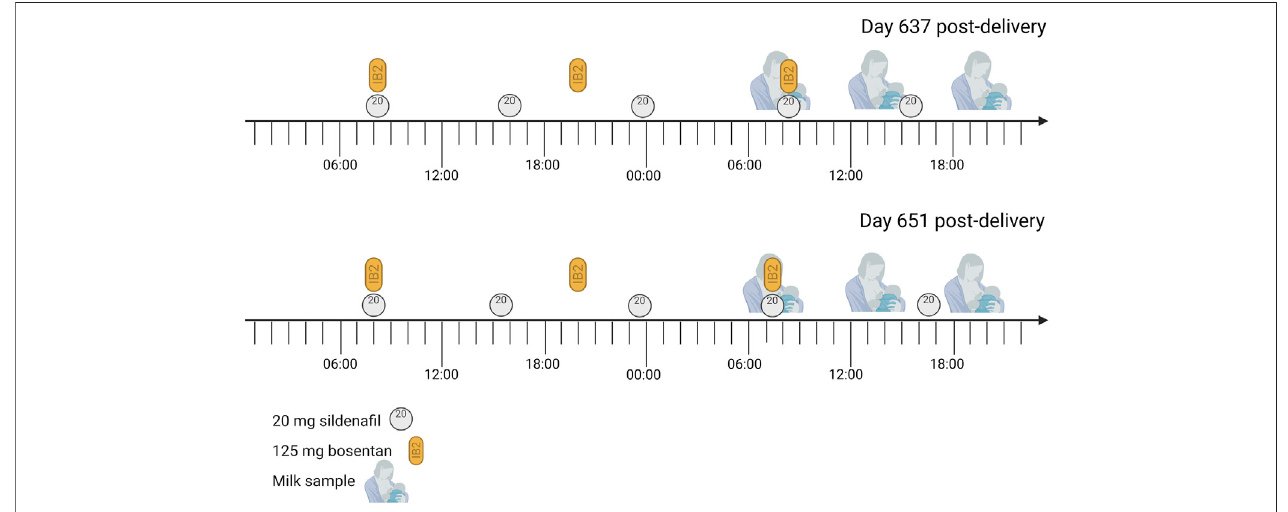
FIGURE 1 | Sampling days The mother was treated with 20 mg sildena fi l three times daily and 125 bosentan twice daily for pulmonary arterial hypertension. She also took 25 µg/day Vitamin D3 (1000 IE) each morning and Ibuprofen (400 mg) on day 637 post-delivery at 14:30, but this is not expected to interfere with the studied medicines. Each expression session, the mother collected a sample from the expressed milk.